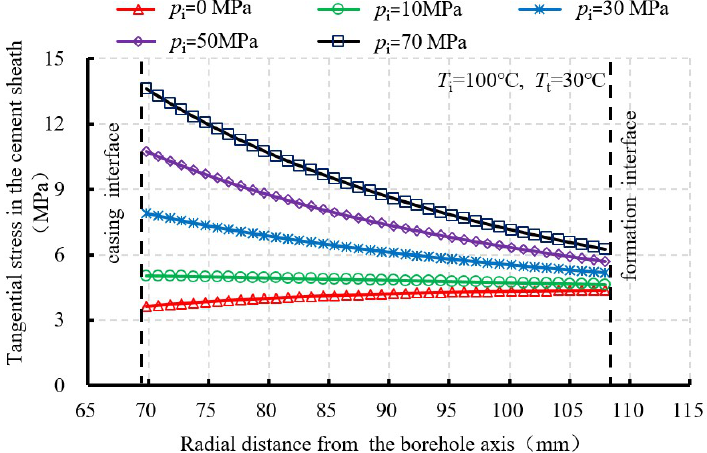
Figure 7. Radial distribution of the tangential stress in the cement sheath under different increased casing pressure p i and decreased temperature of 70 °C at the casing inner wall.